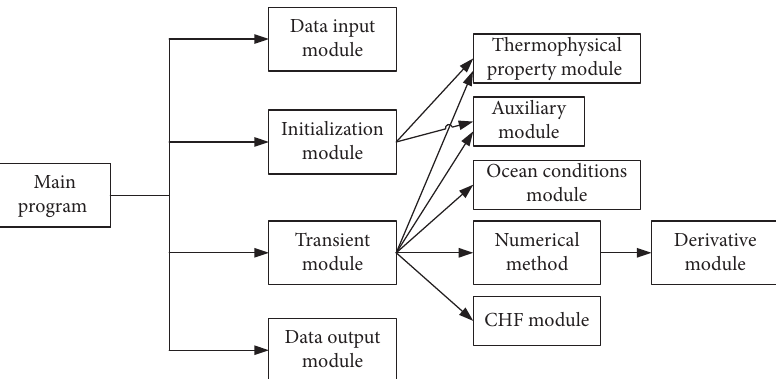
Figure 6: Call relationships of